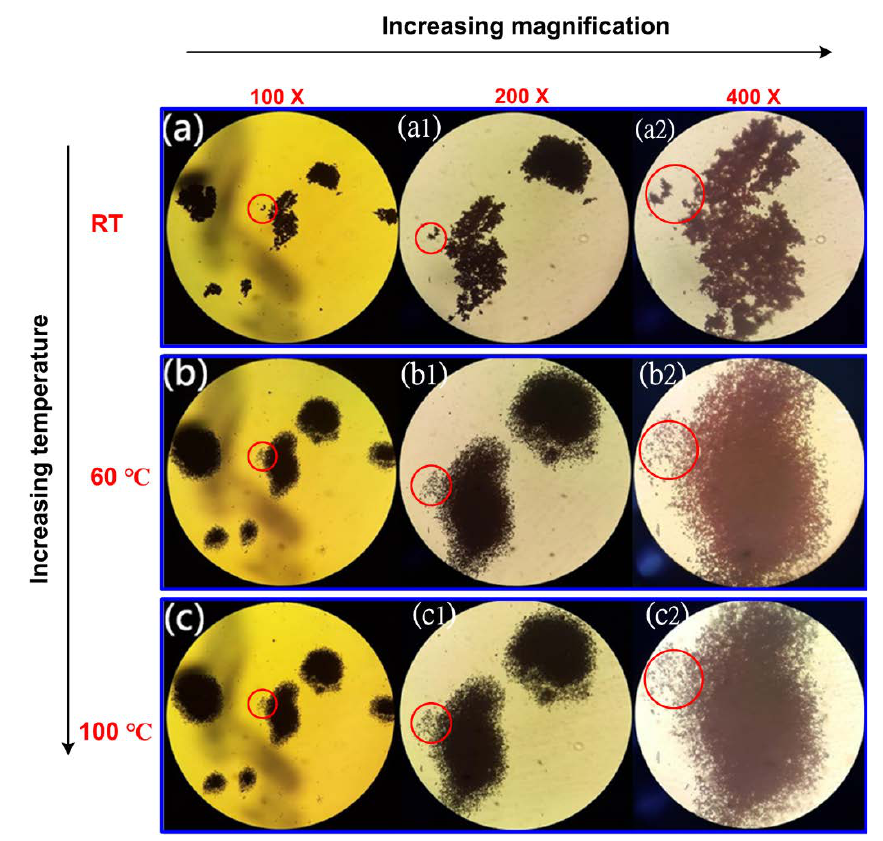
Figure 8. Optical microscopic pictures of Cu-NPs taken at ( a ) RT, ( b ) 60 °C, and ( c ) 100 °C, with 100×, 200×, and 400× magnifications, respectively.